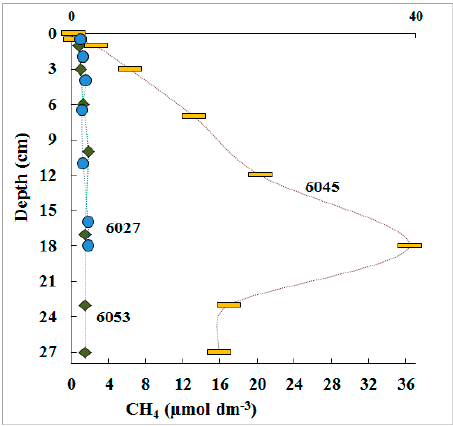
Figure 3. Methane content (CH 4 , µmol dm ‒ 3 ) in pore water of three Laptev See shelf sediment samples.